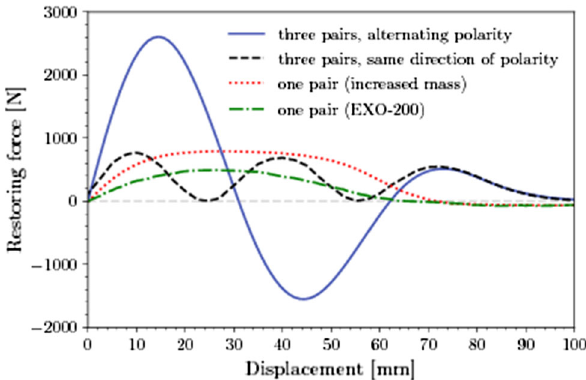
Fig. 2 Simulated restoring force as a function of piston displacement for different magnet configurations. The EXO-200 pump configuration is shown in dash-dotted green. One magnet pair with increased size compared to the EXO-200 design is visualized in dotted red. Dividing the single magnet pair into three pairs with same direction of polarity results in the dashed black curve. By applying our new method with alternating polarity, the blue curve is obtained. The new configuration yields a maximum coupling strength of 2600N, which is a factor 3.3 larger than the initial EXO-200